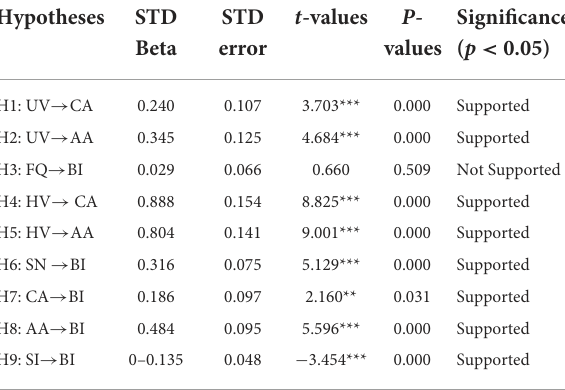
TABLE 6 Structural model and hypothesis testing